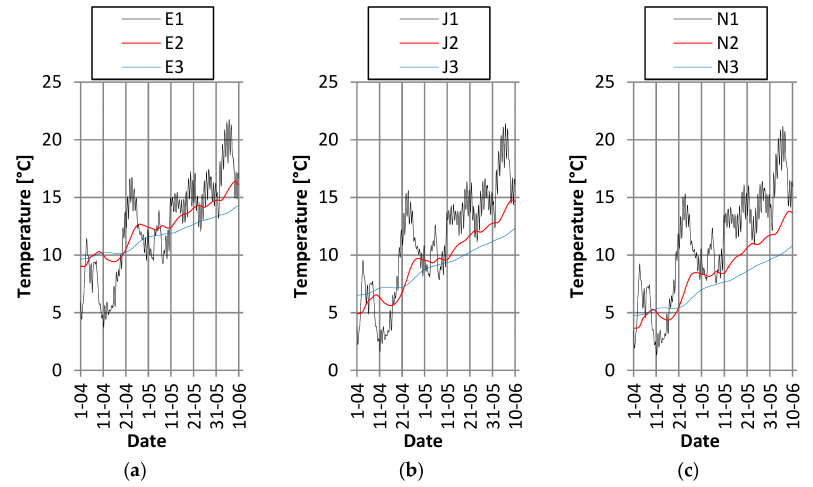
Figure 6. Soil temperature in lines E, J, and N on selected days during the spring